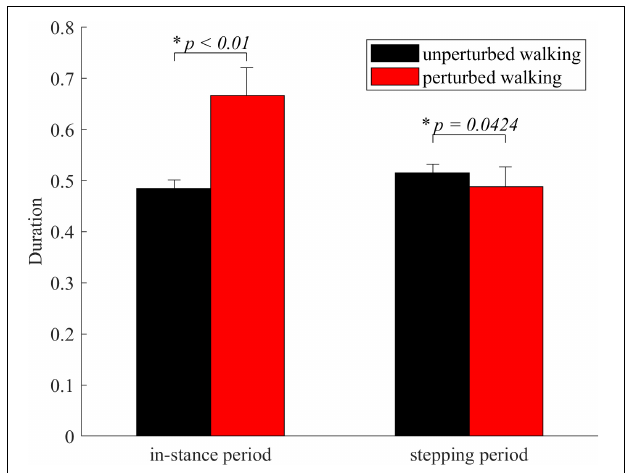
FIGURE 3 | Dimensionless group average and standard deviations of in-stance and stepping periods durations for both experimental conditions. Statistical significance is indicated with an asterisk ( ∗